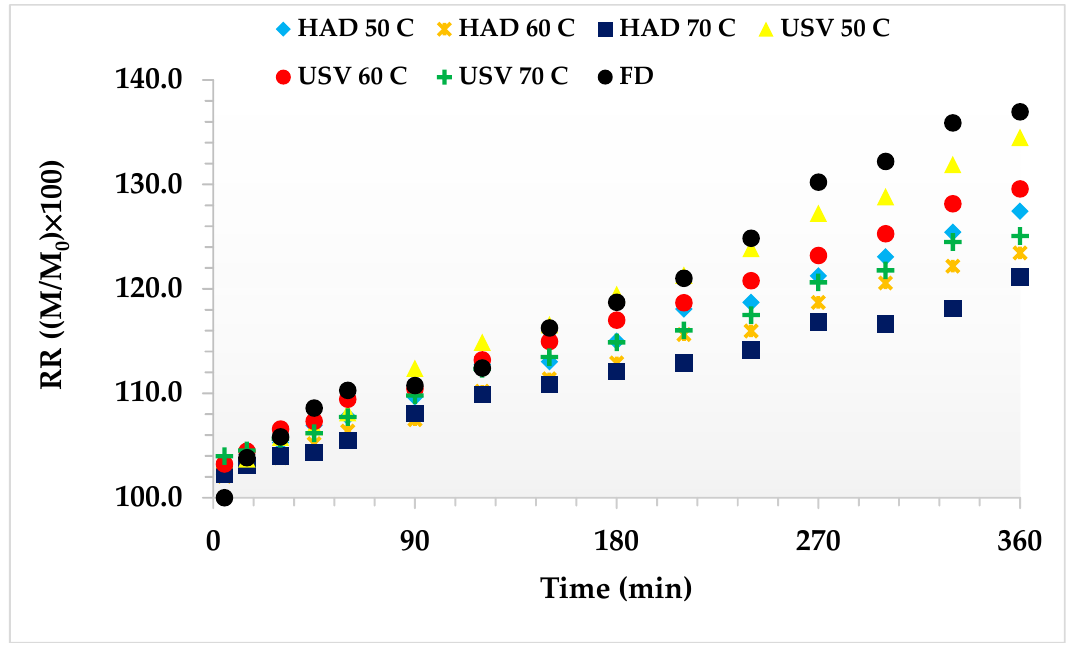
Figure 4. Rehydration kinetic of cherry laurel fruit.